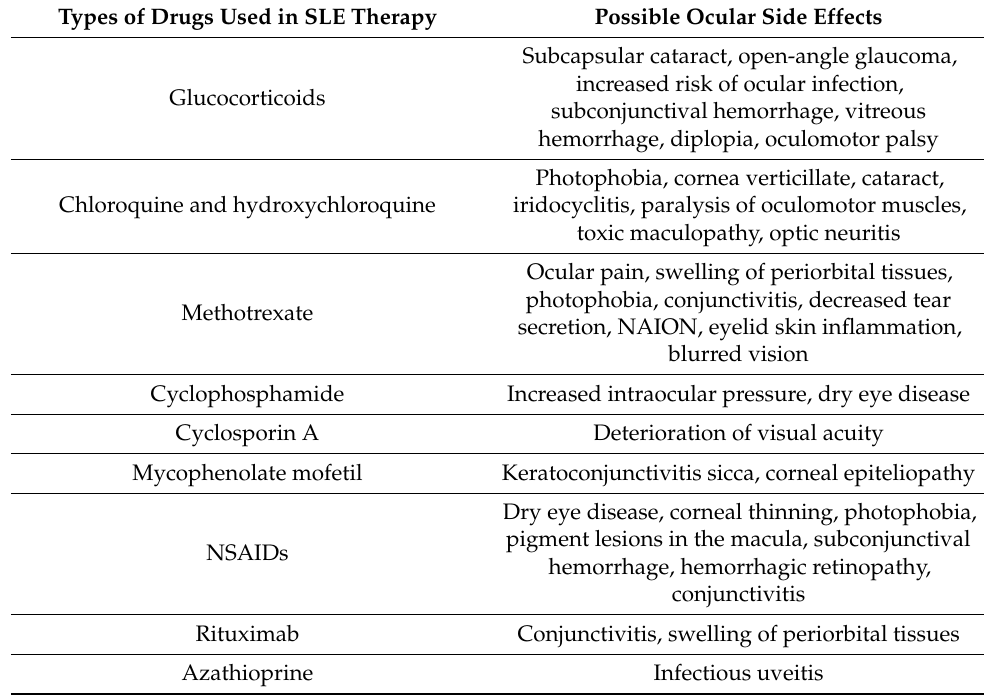
Table 2. Types of drugs used in SLE and their possible ophthalmic side effects. Data from [68–72]. Types of Drugs Used in SLE